Question: How would you classify this visualization?
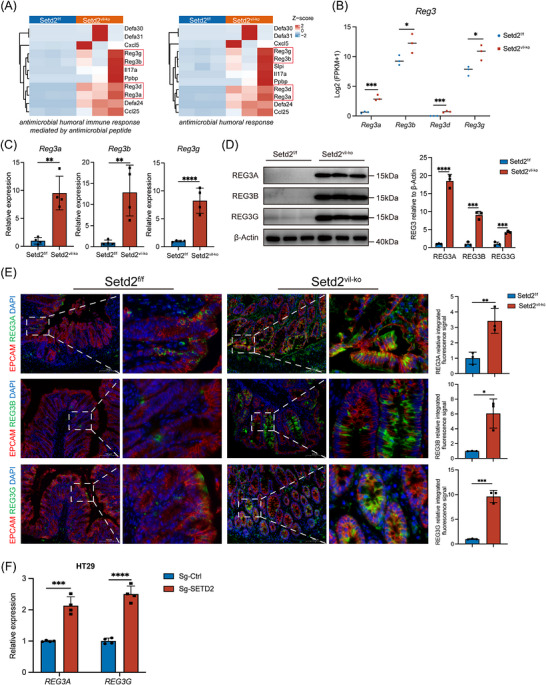
Answer: heatmap